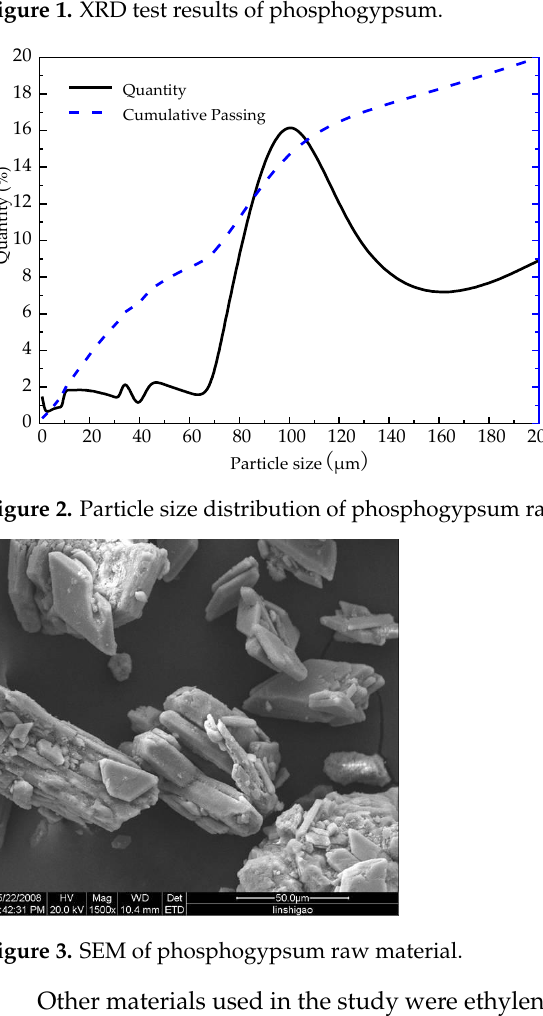
 (5) (3) Solid–solid reaction mechanism: According to this theory, the coexistence of gypsum and carbon can promote decomposition, and its reaction is: Main reaction: